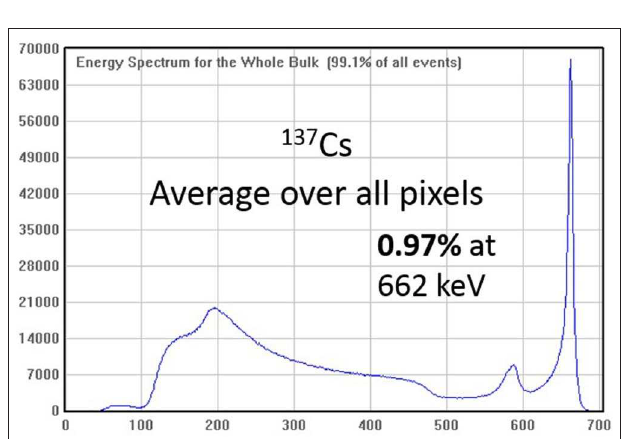
Products (Cremat Cr110) charge sensitive preamplifiers and GAGE Octopus Compuscope [28].